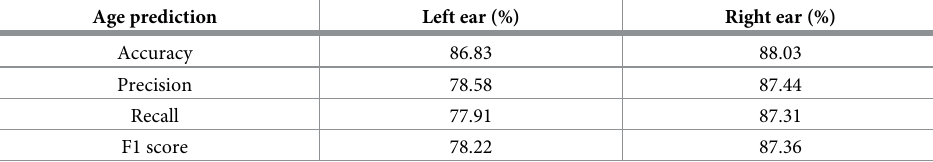
Table 5. Accuracy, precision, recall and F1 score of age prediction for the right and left